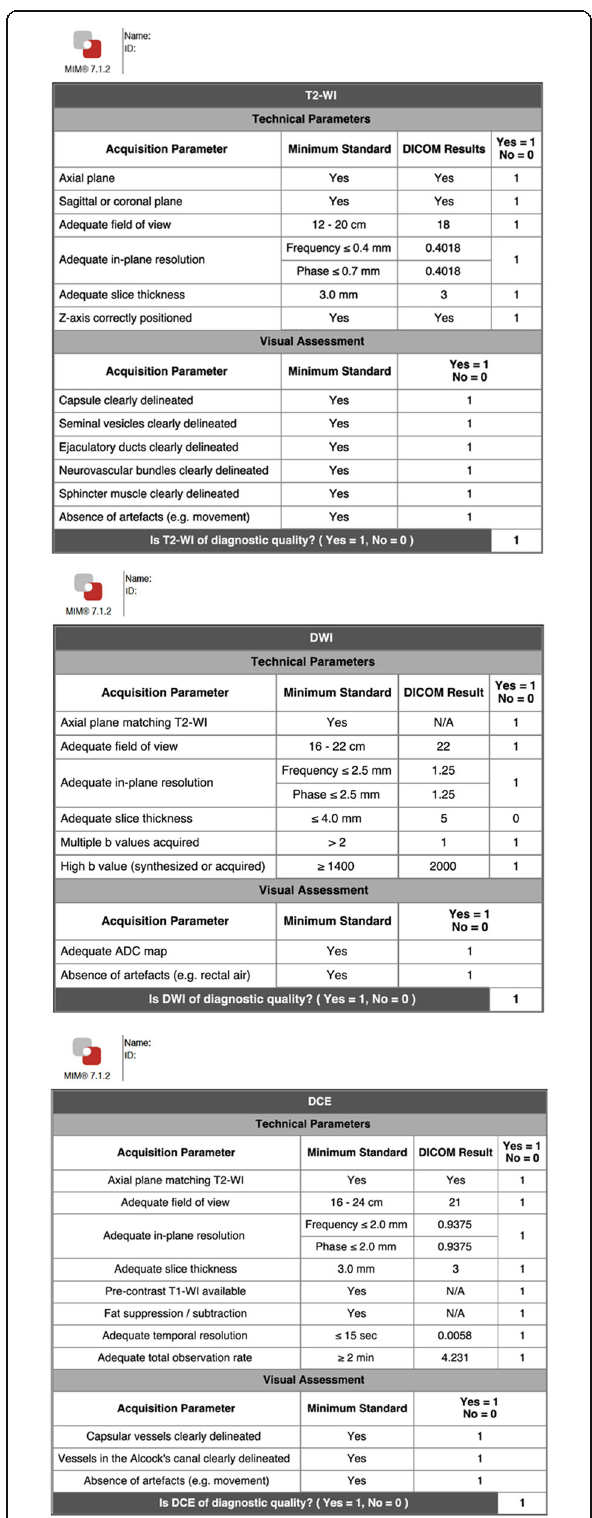
Fig. 3 Structured report obtained using the dedicated PI-QUAL software